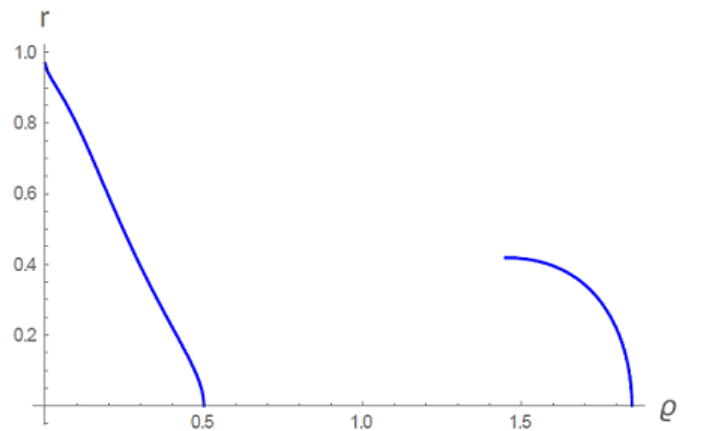
Figure 6. The isopotential (density profile) for t = 0.87 and choice of free parameter (cid:36) 0 = 0.5. Only the stable parts of the profile are shown. The low density branch and high density branch contain the same amount of gel material, and respectively represent the swollen and collapsed phases at the transition temperature